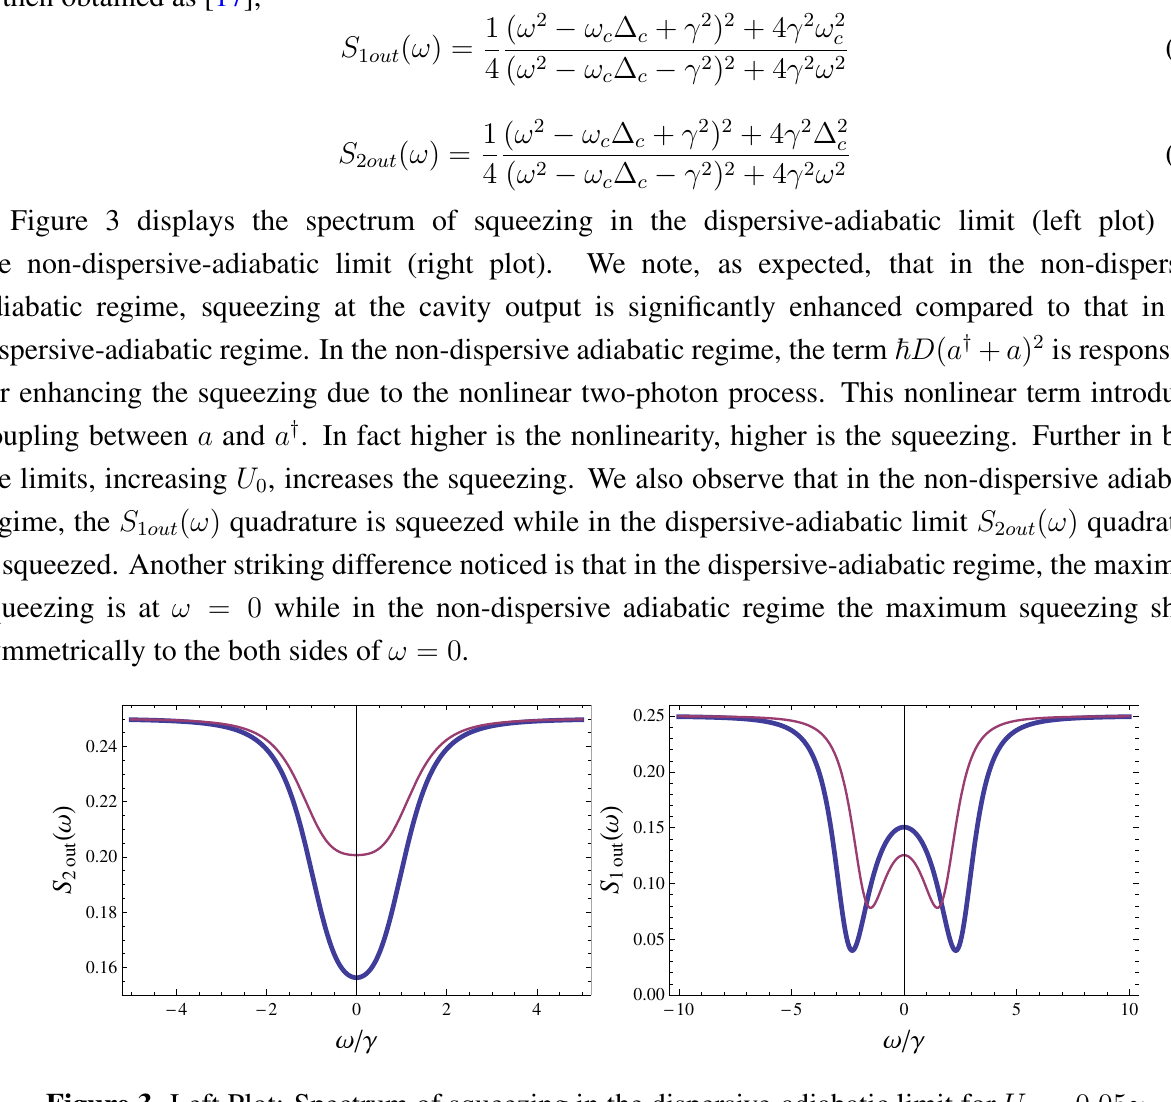
Figure 3. Left Plot: Spectrum of squeezing in the dispersive-adiabatic limit for U = 0 . 1 γ (thick line), α = 0 . Right Plot: Spectrum of squeezing in the (thin line) and U 0 = 0 . 5 γ (thin line) and U strong-coupling-adiabatic limit for U 0 = γ In both the curves, ω c